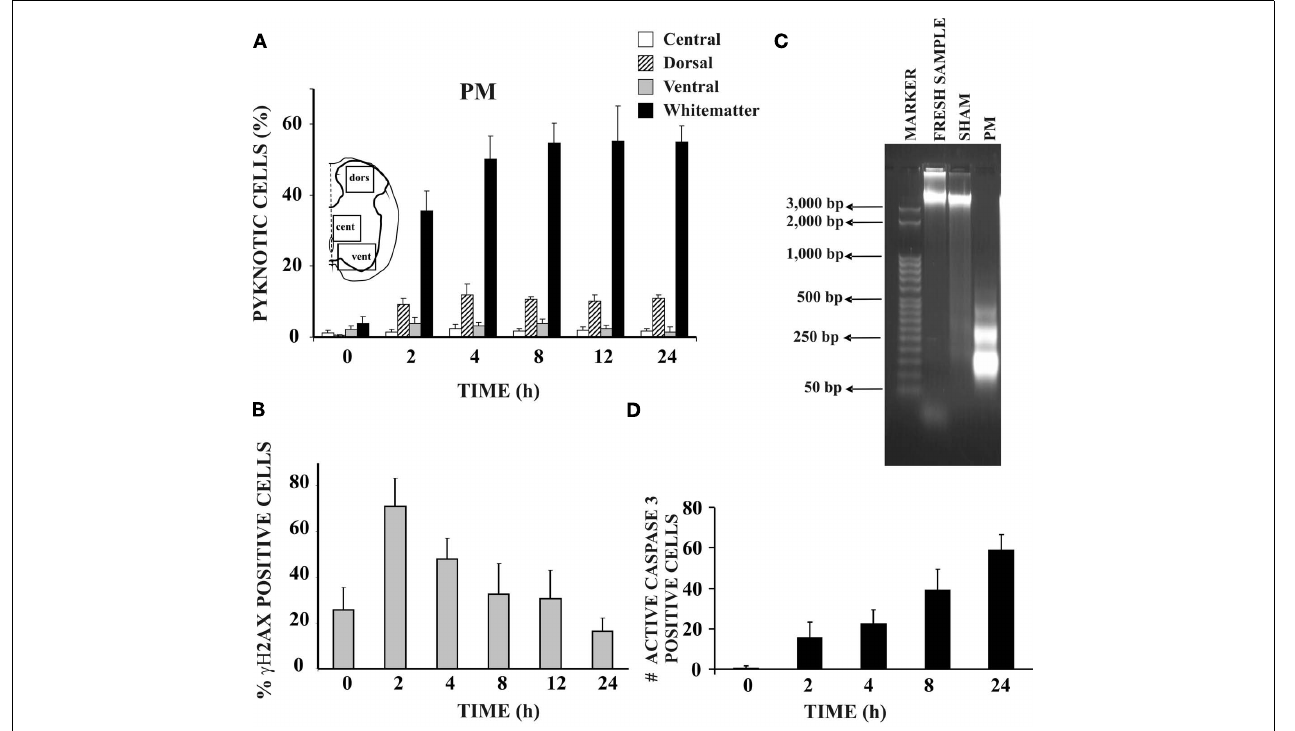
control spinal cords (freshly dissected, lane 2), from sham spinal cords (kept in vitro for 24h in Krebs solution, lane 3), or PM treated spinal cords (1h PM treatment followed by 24h recovery in Krebs solution, lane 4). Note DNA laddering (due to internucleosomal DNA fragmentation) in the PM treated sample only ( n = 3 for each sample). Lane 1 shows DNA ladder marker (50bp steps). (D) Histograms indicate number of active caspase-3 positive cells in the white matter of the PM treated spinal cords (average of six slices from two spinal cords) at different time points after 1h of PM